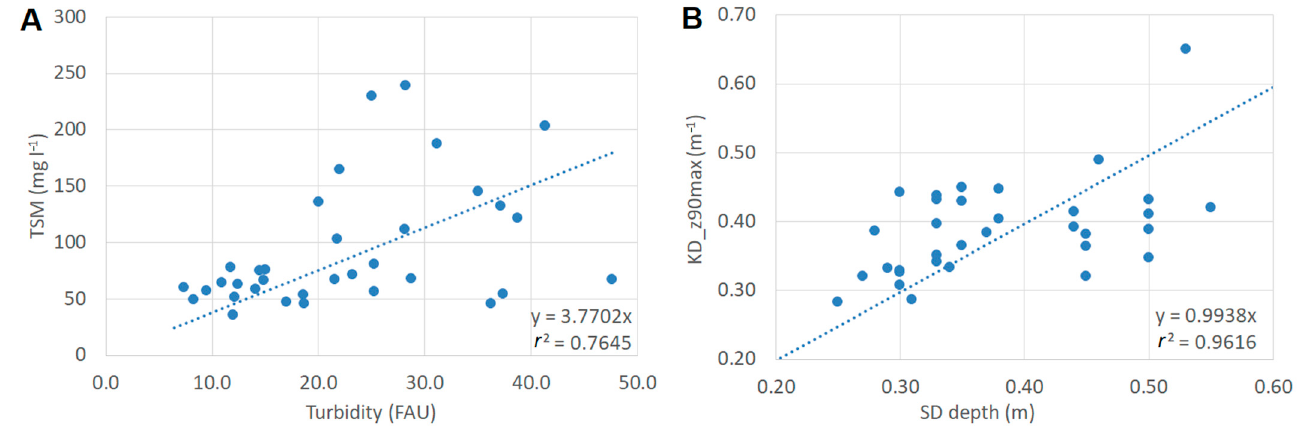
Figure 6. For the same geographical point in the lagoon, ( A ) relationships between the values of turbidity measured in the water lagoon and the estimated values of suspended matter (TSM); ( B ) relationships between the Secchi disk (SD) measurement and the diffuse attenuation coefficient (KD_z90max).